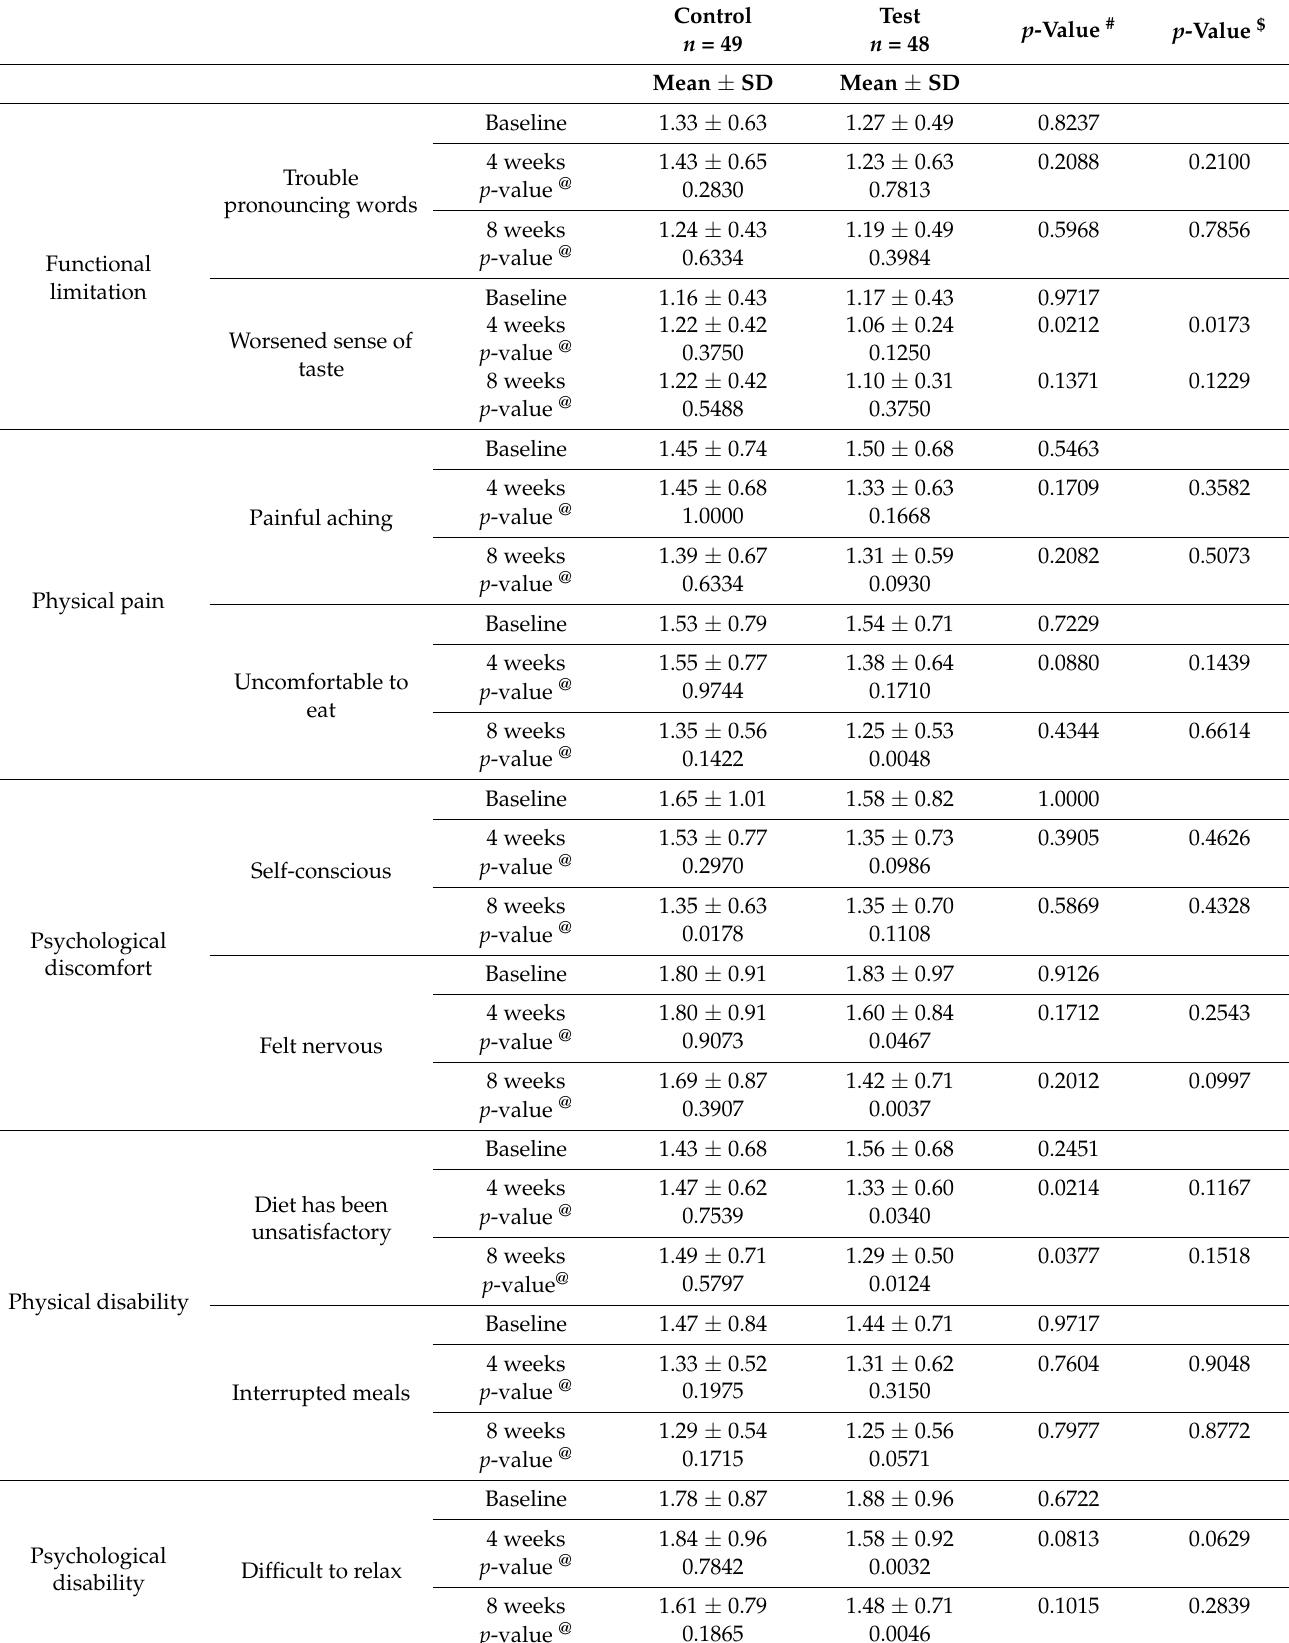
Table 5. Patient-reported outcome